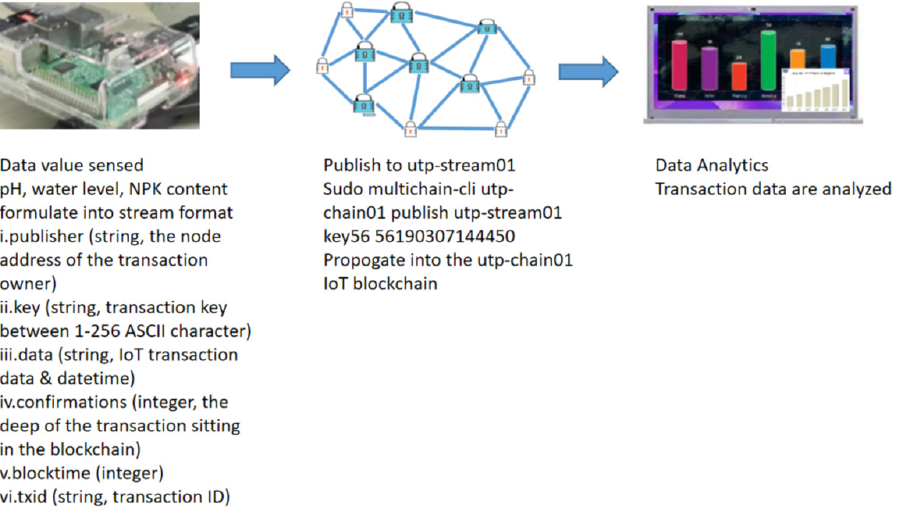
Figure 4. IoT blockchain transaction data flow.